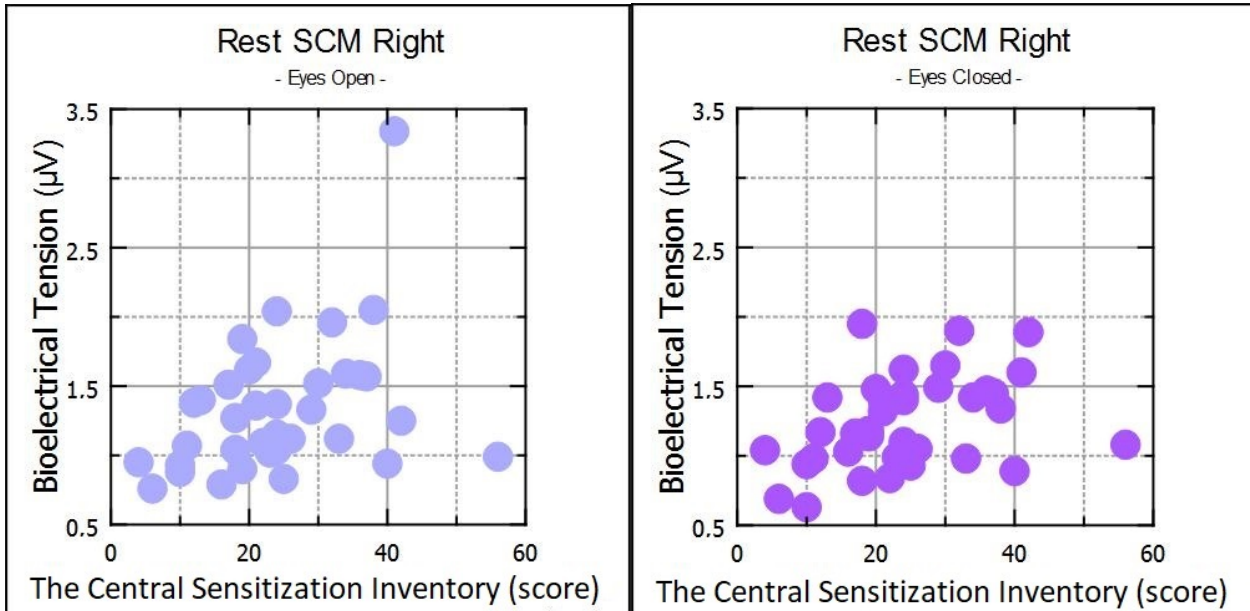
Figure 2. Scatter plot for SCM-R in rest for open eyes and closed eyes.